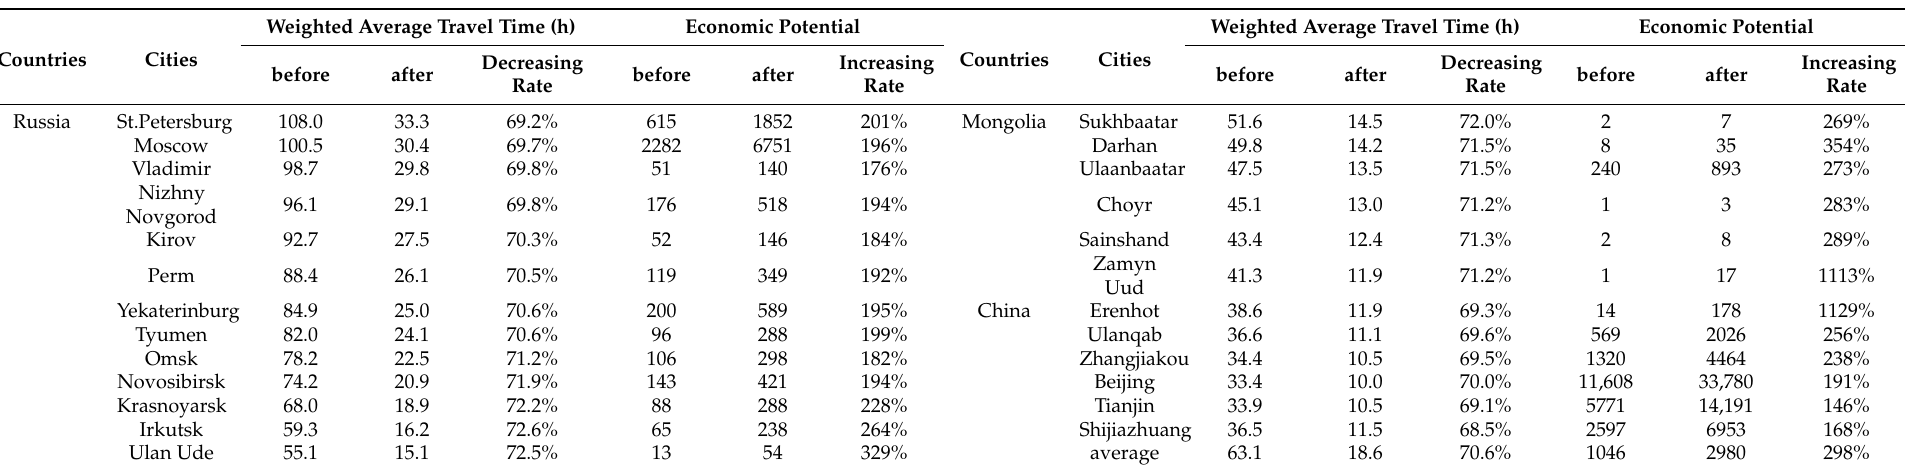
Countries Cities